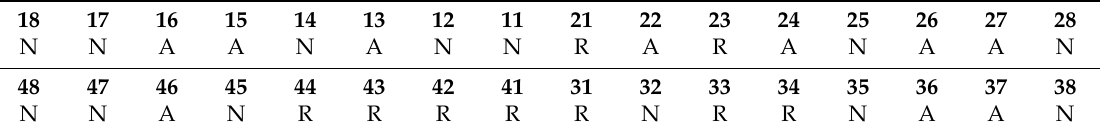
Table 1. Table of the dentition showing which teeth are missing and have anomalies.